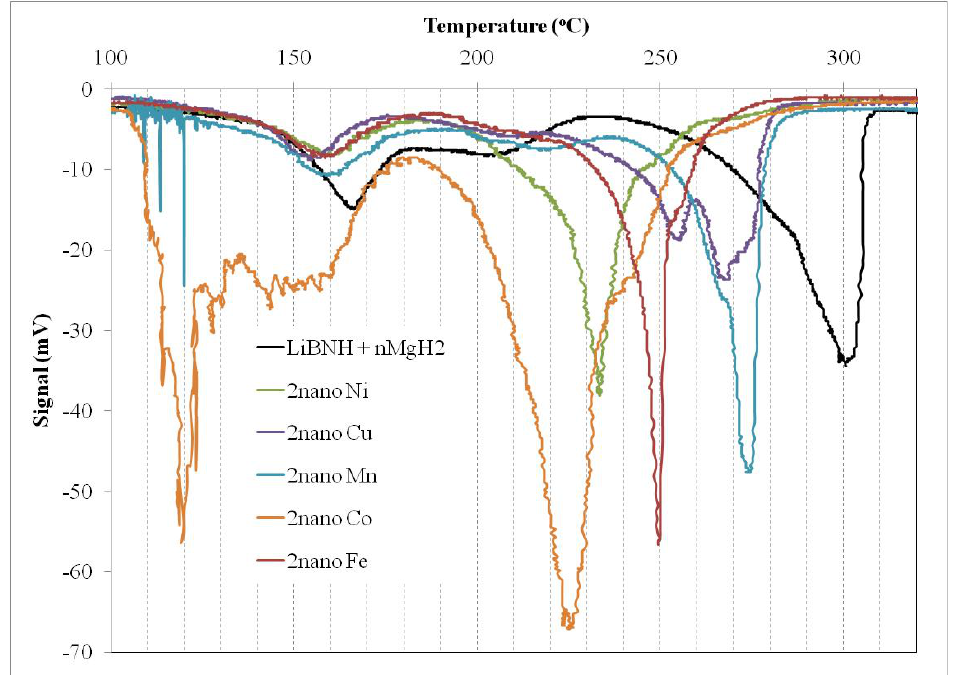
without and with 2 mol% 2